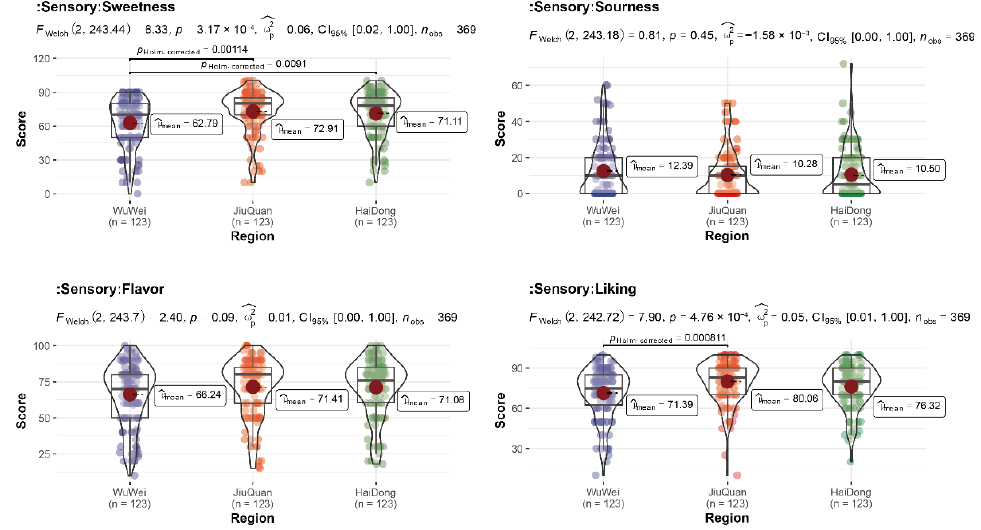
Figure 1. Stats-violin plot of testers ’ sensory evaluation of pepino in three regions.